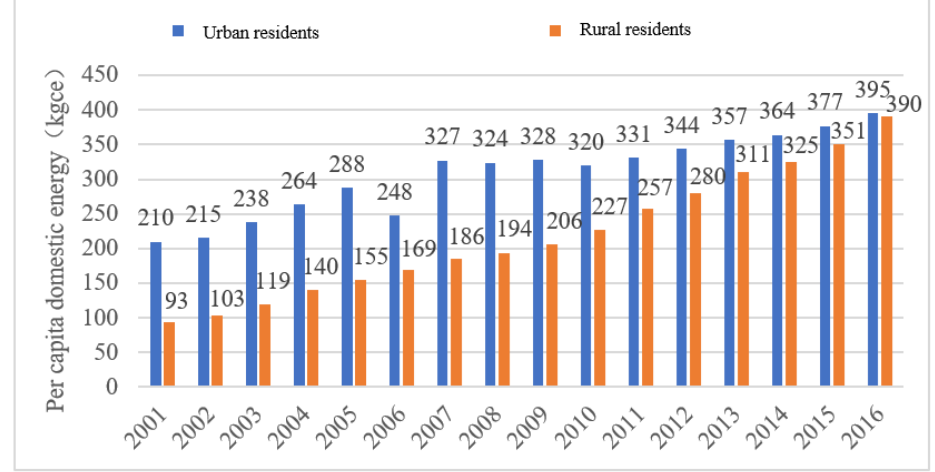
Figure 2. Urban/rural per capita energy for living. Scheme 2002.